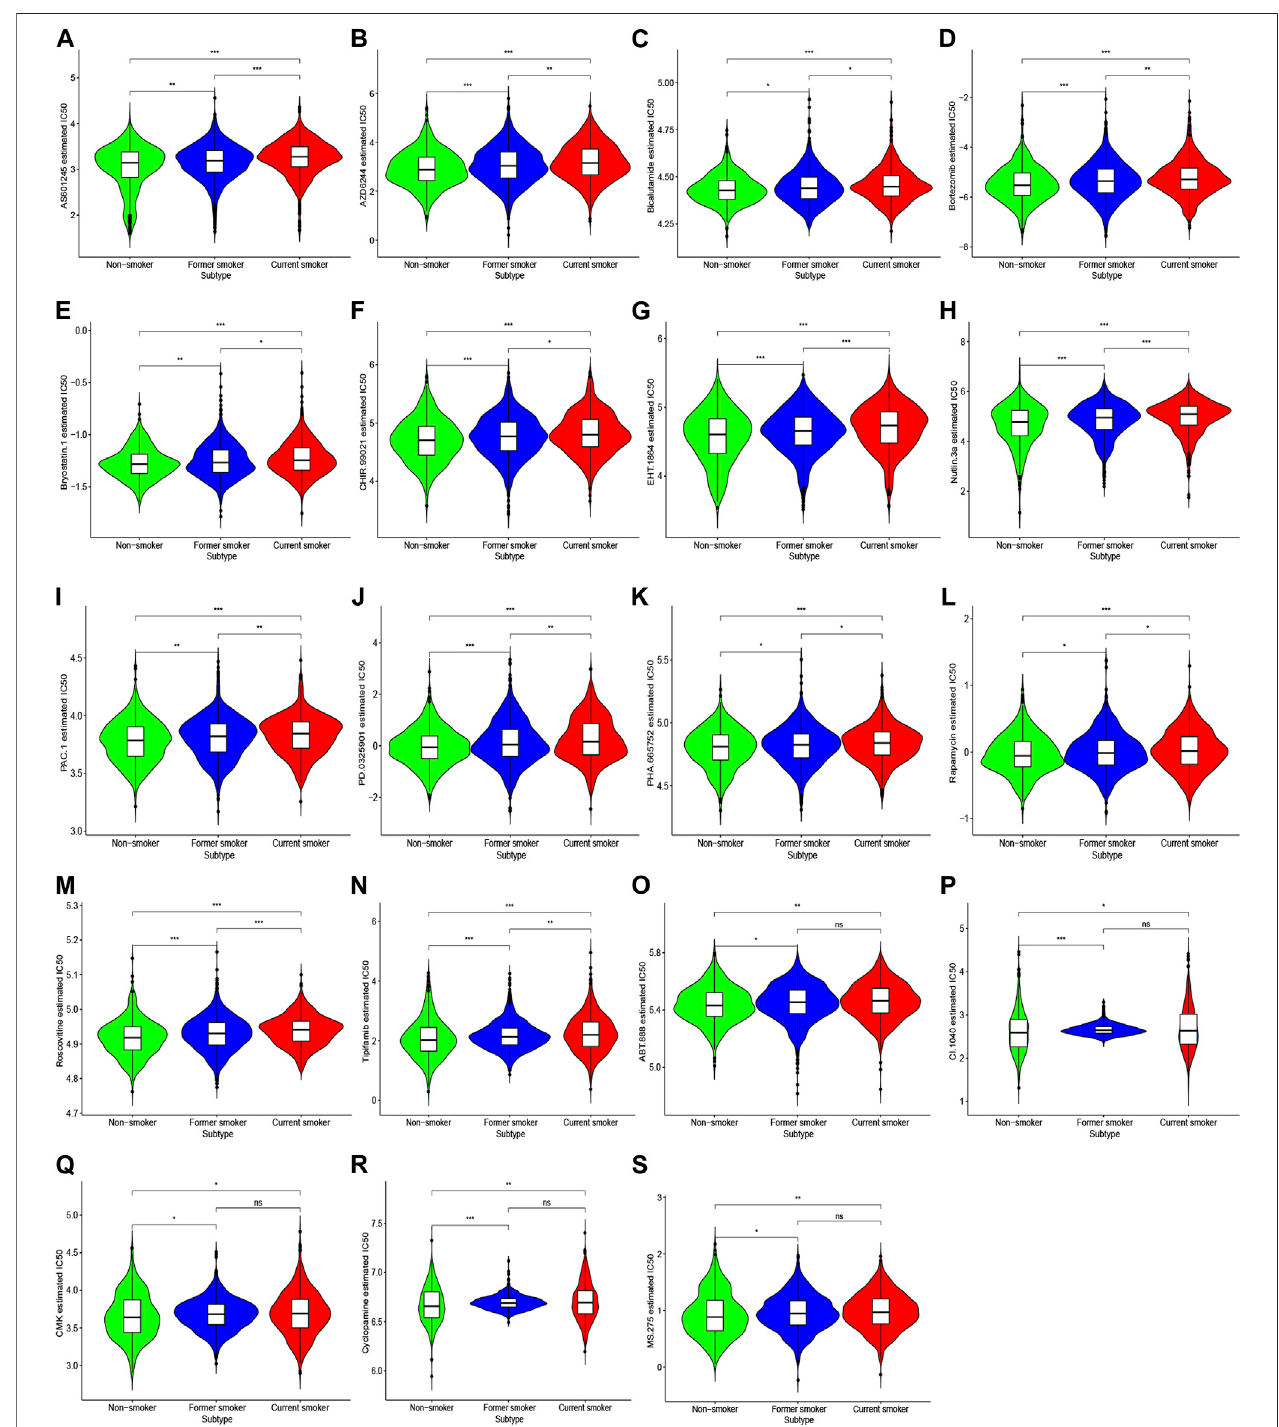
FIGURE 8 | IC50 of response to chemotherapeutic drugs in patients with different smoking histories. Red, blue, and green represent current smokers, former smokers, and non-smokers, respectively.